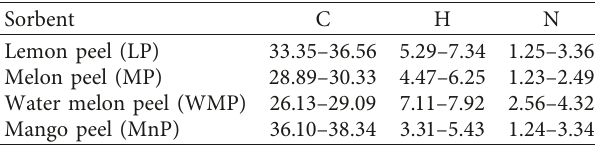
Table 2: Percentage (%) of carbon, hydrogen, and nitrogen content in sorbent